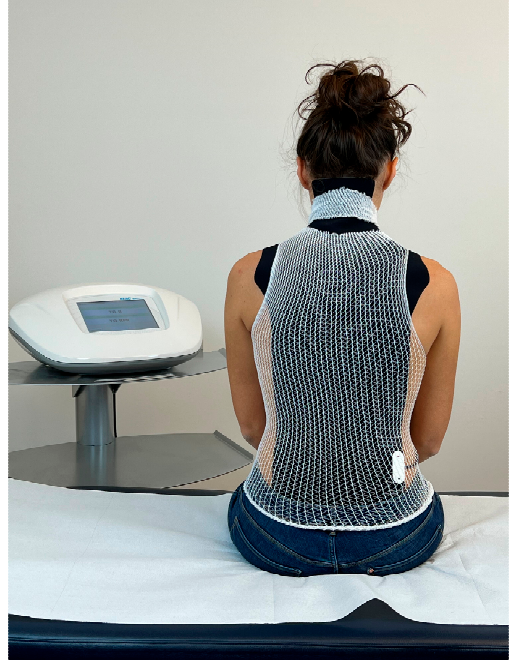
Figure 1. Example of the administration of REAC antalgic neuromodulation (ANM). The visible black part consists of the outer part of the asymmetric conveyer probe (ACP). White tubular elastic mesh holds the ACP in place. The ACP is connected with the device through a cable.